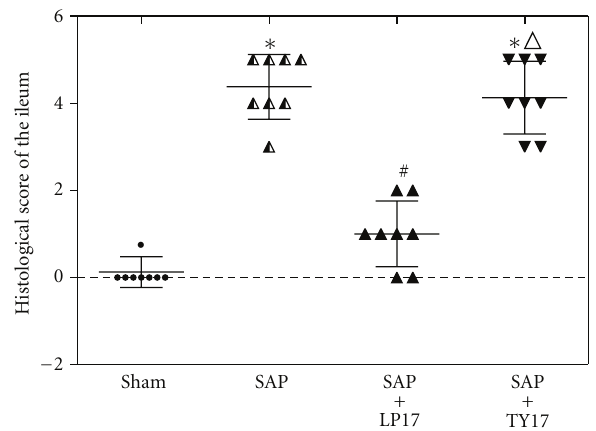
Figure 9: Histological score of the ileum at 6h after the induction of